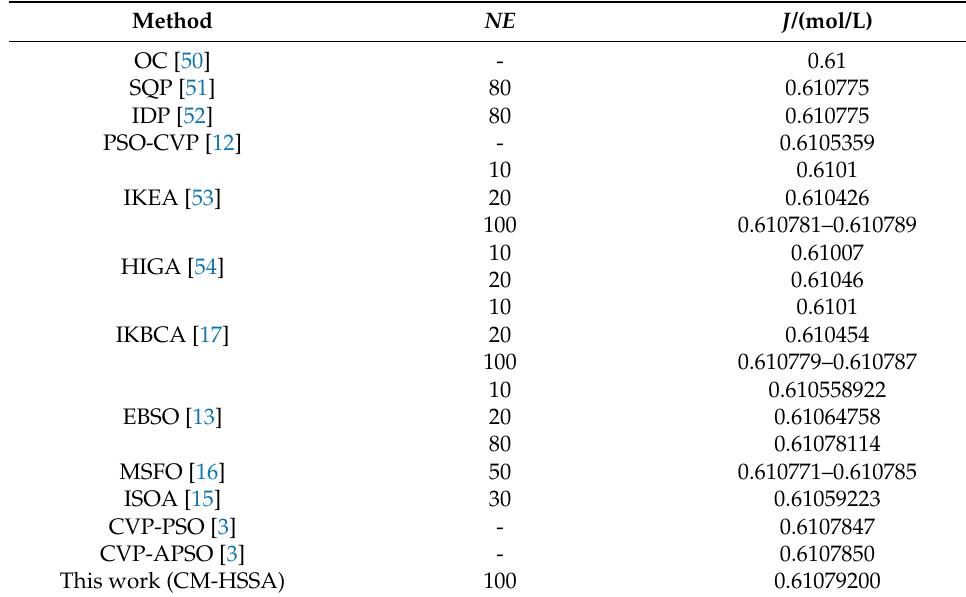
Table 5. Comparison of optimization results for Problem 1.